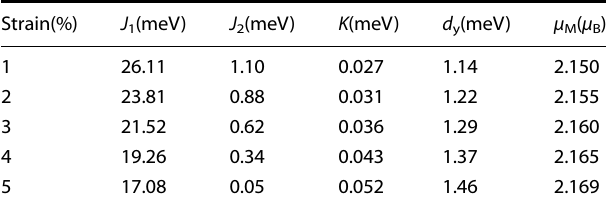
Table 2. The calculated magnetic parameters of NN and NNN exchange coupling J 1 and J 2 , magnetic anisotropy energy K , DMI parameters d y and magnetic moment μ M of V atom when the tensile strain varies from 1 to 5% in monolayer VCuSe 2 .